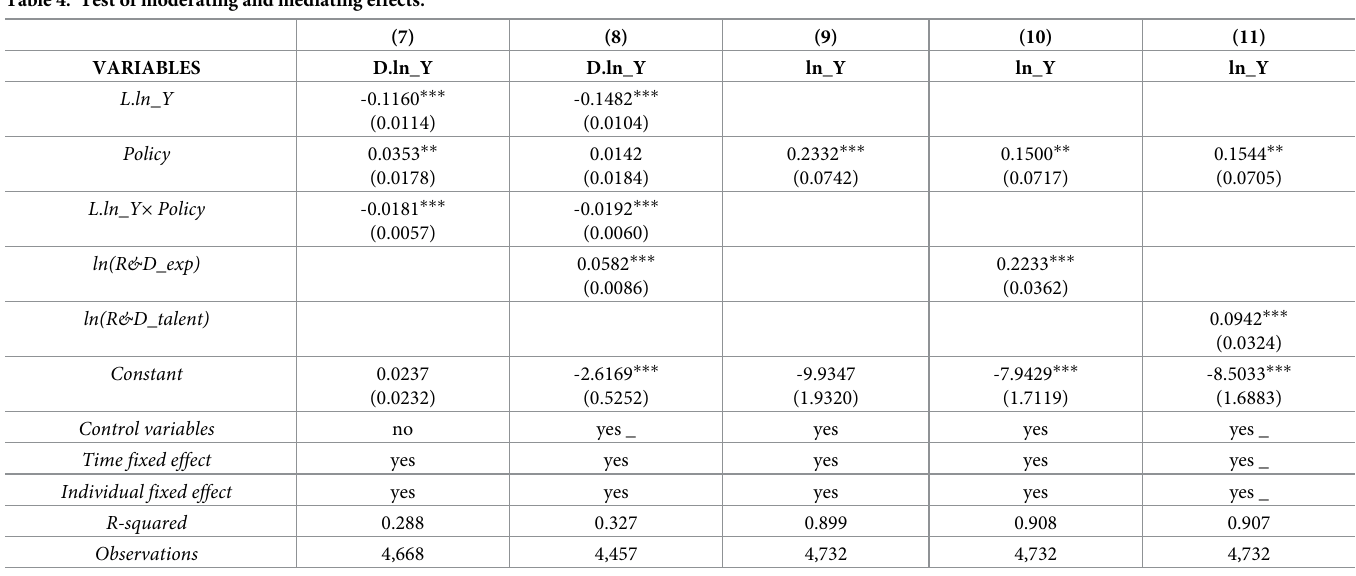
Table 4. Test of moderating and mediating